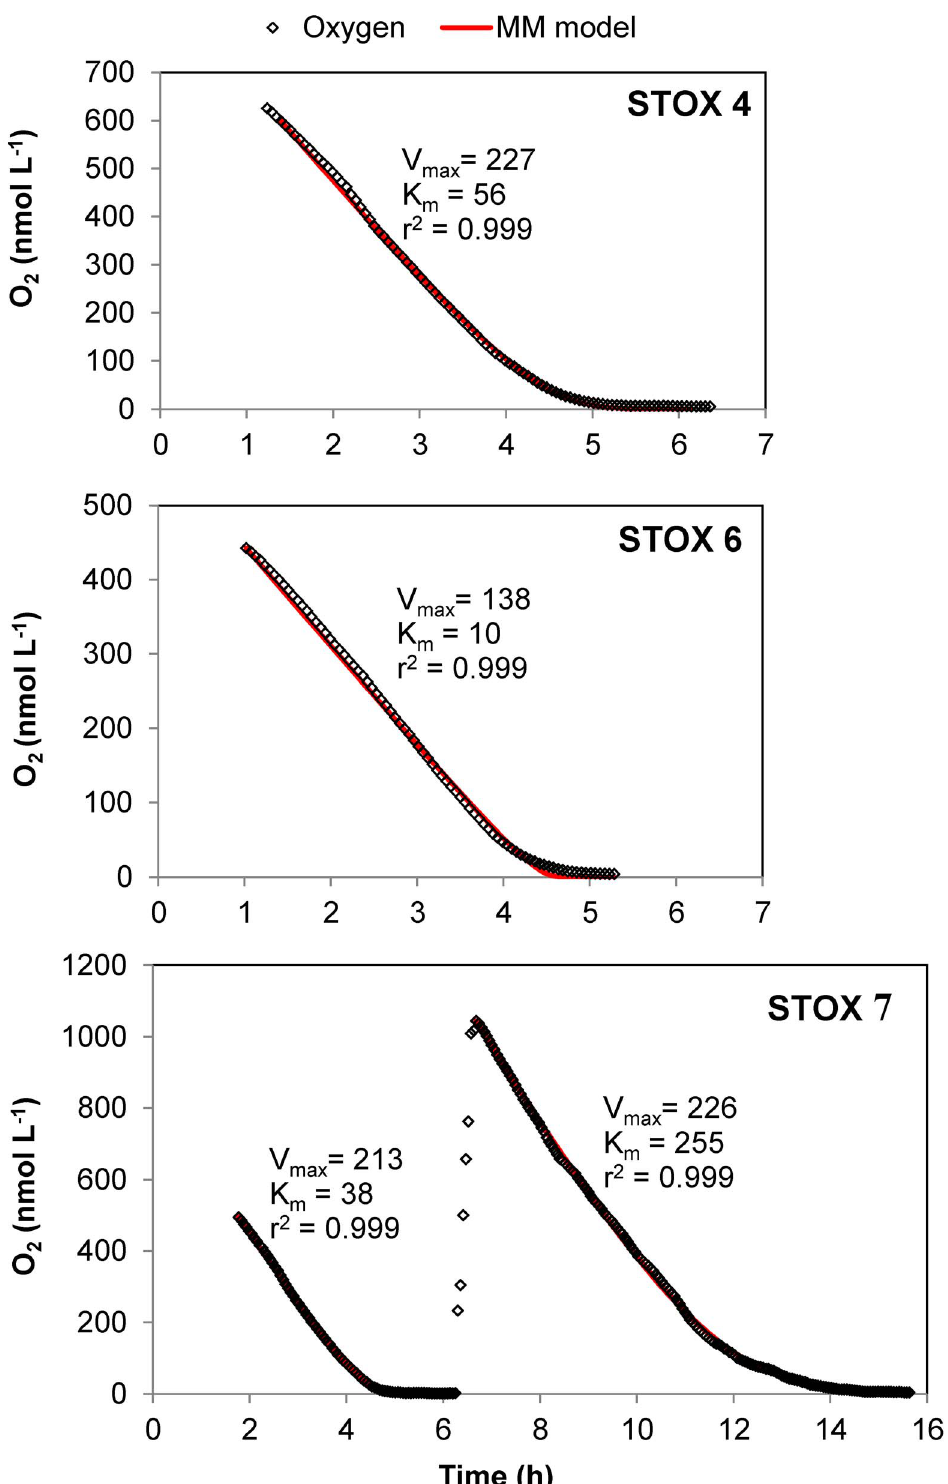
Figure 5. Examples of modeling of oxygen depletion curves in coastal seawater samples. Oxygen depletion experiments from three incubation bottles (4, 6, 7) from St. 2 (Marselisborg Marina), September 2011. Air saturated water was injected in bottle ‘‘STOX 7’’ once O 2 was depleted (6 h). The dots show O 2 values recorded by the STOX sensor. Maximum rates (V max ) and half saturation constants (K m ) were determined by least squares fits (red solid line) using Eq. (2), derived from Michaelis-Menten kinetics. The method gave a relatively poor fit that might result in an underestimation of the K m value for the ‘‘STOX 6’’.